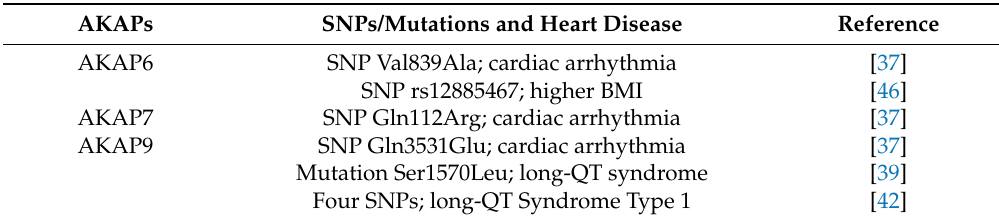
Table 1. Polymorphisms/mutations in AKAPs and